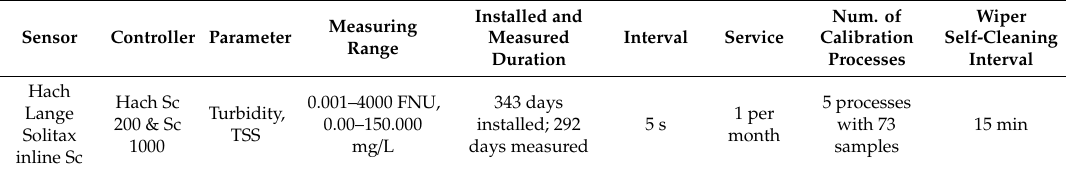
Table 1. Technical data of TSS sensors